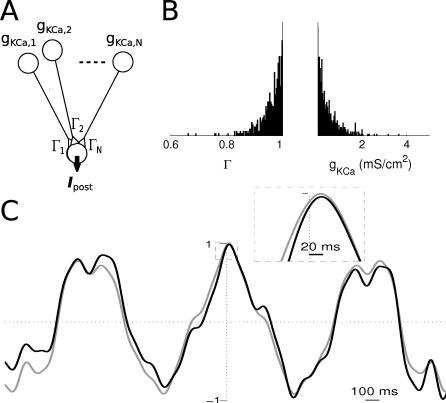
Slightly Degraded Anticipatory Response from a Disordered, Heterogeneous Population of Adapting Neurons and Depressing Synapses(A) Model scheme for a less constrained anticipatory architecture: presynaptic neurons have different values of the IKCa conductance (gKCa) responsible for SFA, and their synapses have varying degrees of STD (parameter Γ).(B) Exponential distributions of gKCa and Γ, by which these parameters are randomly and independently distributed in presynaptic neurons and synapses, respectively.(C) Cross-correlation function between I
post and I
in superimposed on autocorrelation function of I
in displaced by 17 ms. The output is a slightly degraded version of an anticipation of the input. Inset: zoom on central peak (dashed square).